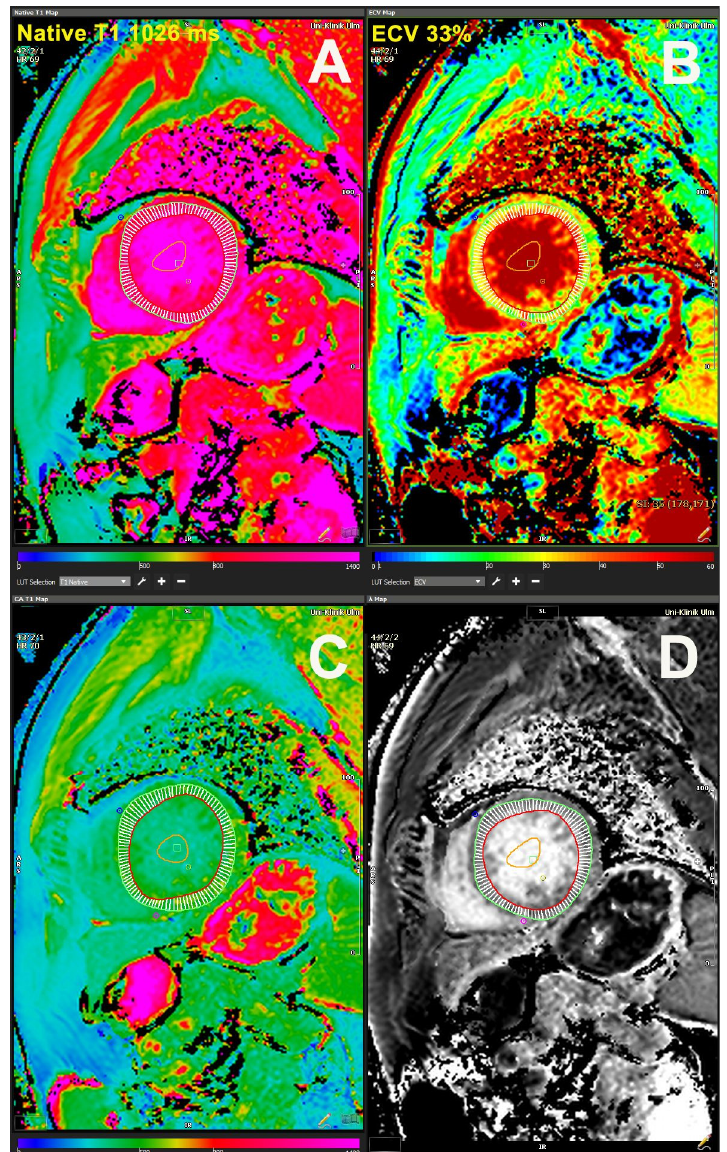
Figure 2. T1 mapping and extracellular volume fraction obtained by cardiac magnetic resonance.